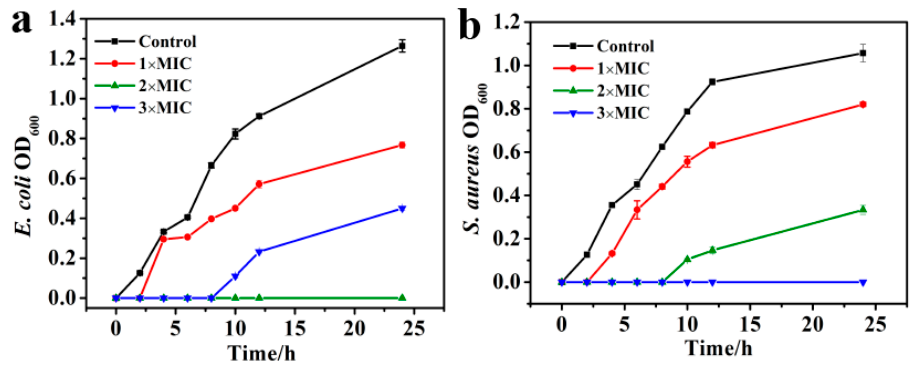
Figure 4. Inhibition effect of P-doped CQDs on the growth of ( a ) E. coli and ( b ) S. aureus . In addition, different concentrations of P-doped CQDs (0, 0.82, 1.23, 1.44 mg/mL) were added into the bacterial LB medium to form the LB plate. After incubation for 12 h, bacterial colonies were generated on the LB culture plate. The visual evidence of the antibacterial effect was displayed on the culture plate. The viability of E. coli and S. aureus the MIC experiments.